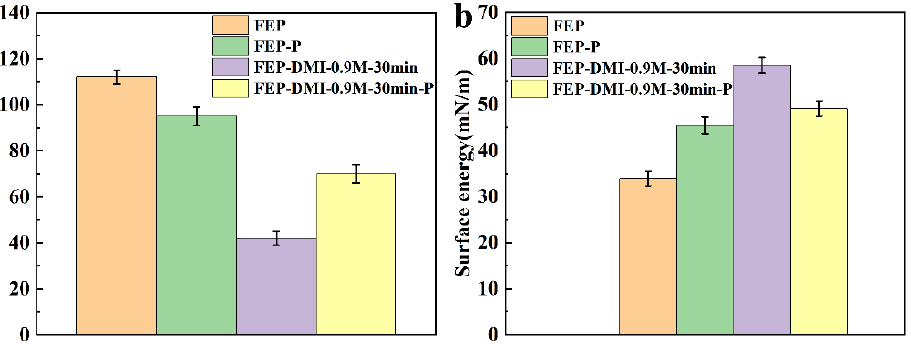
Figure 10. Comparison diagram of the contact angle and surface energy of FEP films under different activation conditions of the sodium naphthalene-DMI system: ( a ) contact angle, ( b ) surface energy.